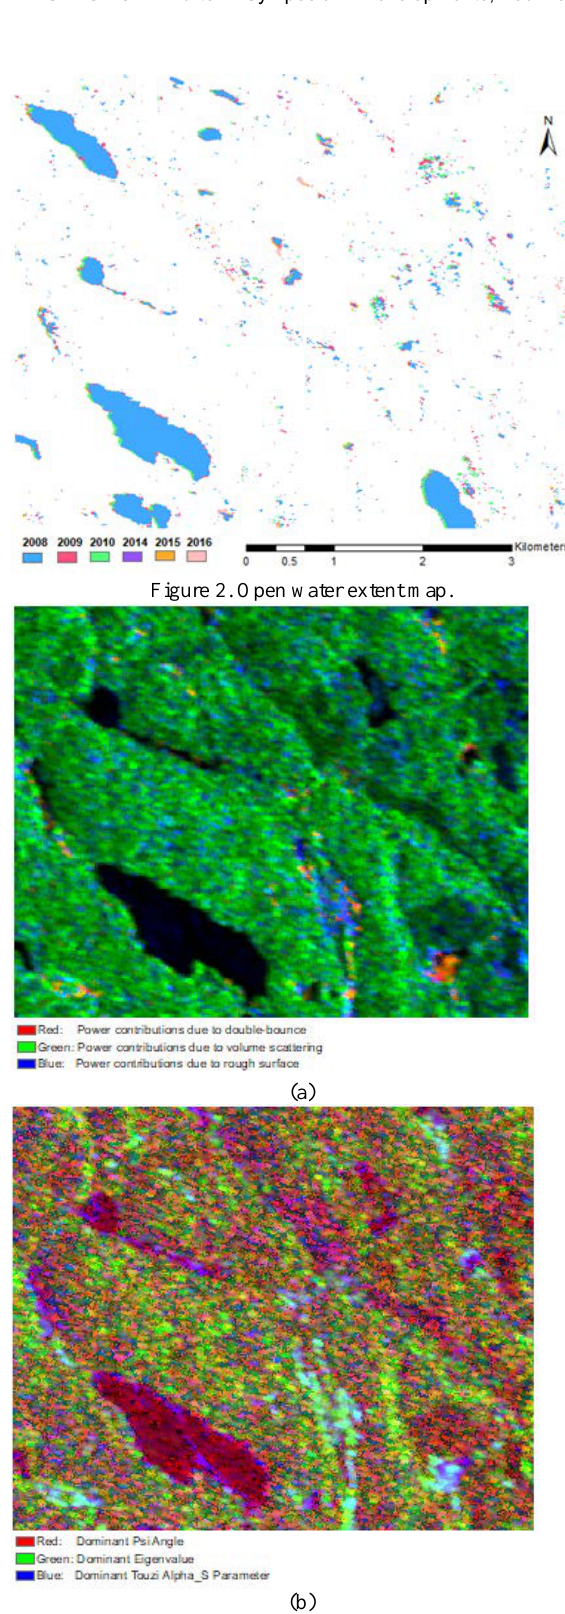
Figure 3. Polarimetric decomposition image. (a) Freeman- Durden decomposition. (b) Touzi decomposition. Figure 4. Flooded vegetation map with colour ranging from orange to blue, as orange colour indicates a high probability of flooded vegetation area and blue indicated low probability. Overlaid beaver activity locations where star indicates present of beaver, a red circle with star indicated beaver dam, and ping circle indicated beaver